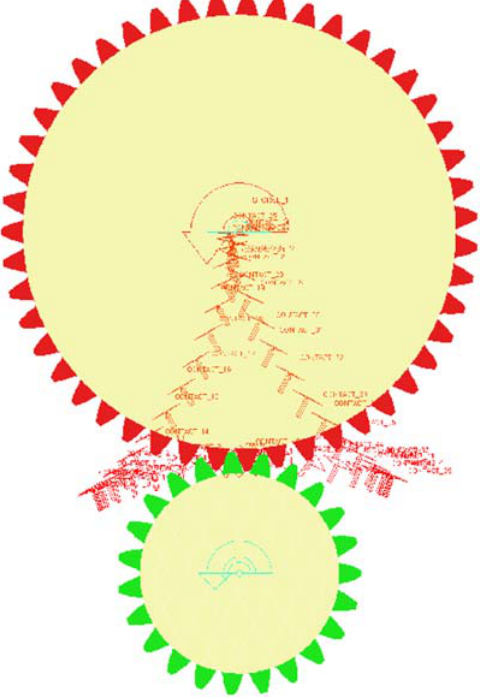
Fig. 8. MBDM of CRC gear